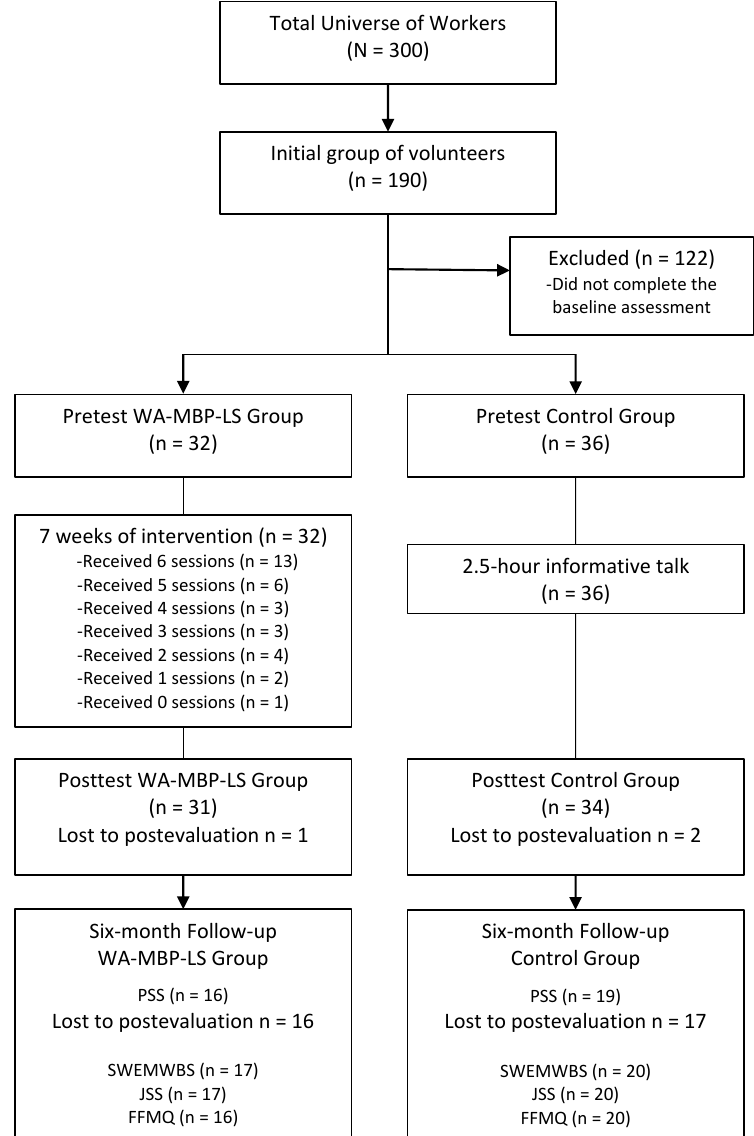
Figure 1. Flow of study participants.